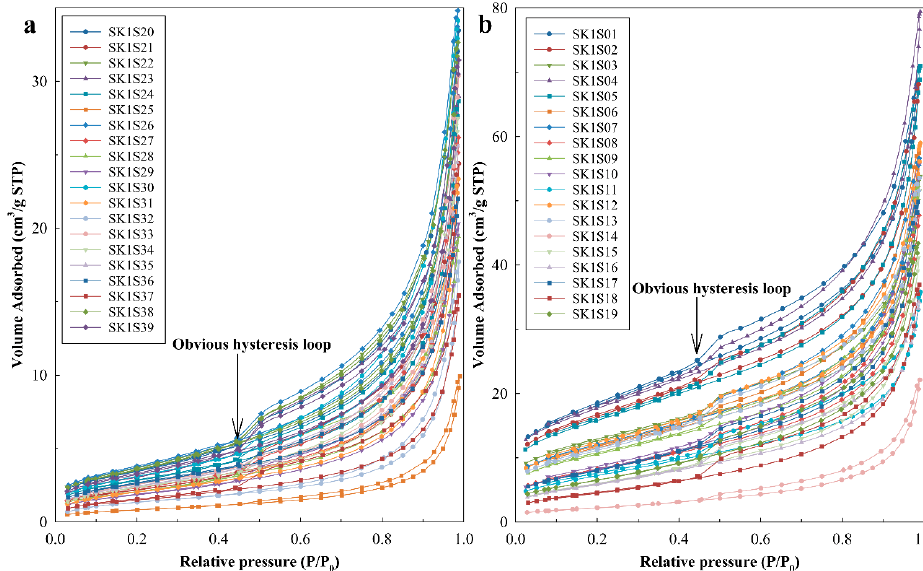
Figure 6. Low-pressure nitrogen adsorption/desorption isotherms of studied lacustrine samples in ( a ) K 2 qn 1 and ( b ) K 2 qn 2,3 .